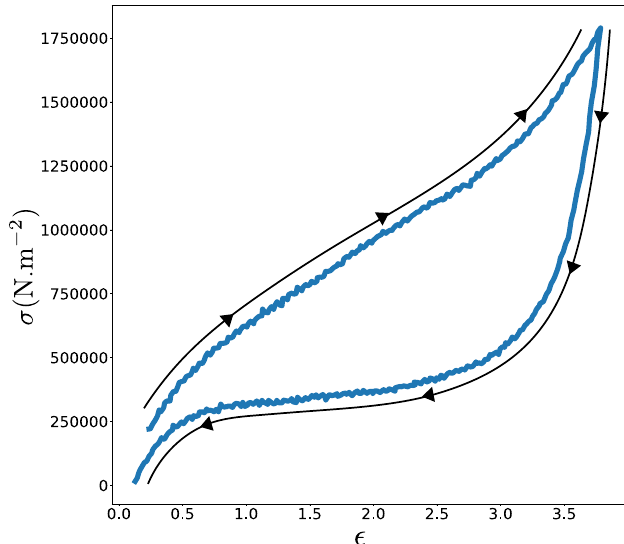
Fig. 6. Traction curve of an elastic rubber balloon. The stress σ is plotted as a function of the relative elongation of the band (cid:15) . Black arrows show the path of the deformation. Their is a non-linear stretching deformation (arrows upwards). The loos- ening (arrows downwards) does not follow the initial curve, a characteristic feature of the plastic domain.